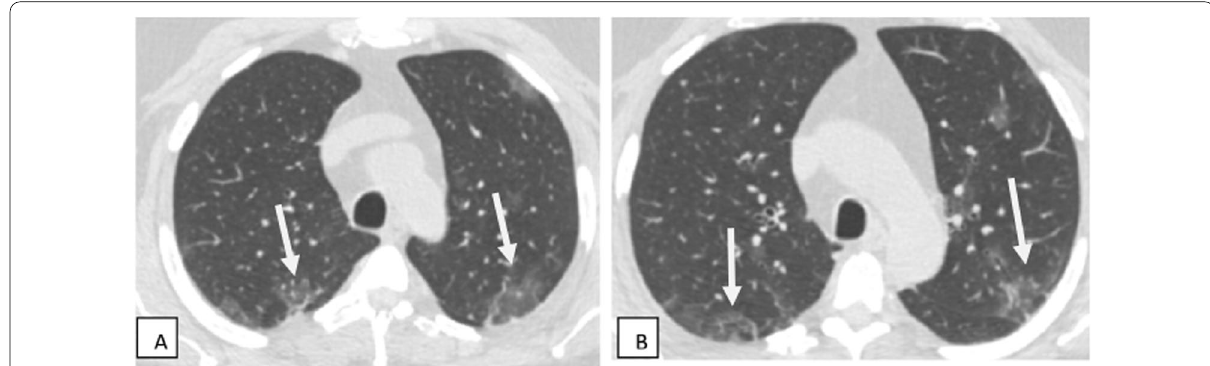
Fig. 1 Male patient aged 62 years old with recent history of cough and mild dyspnea. Axial CT images ( A , B ) show ill‑defined peripheral patchy areas of ground‑glass densities seen at both lungs with subpleural position (white arrows) (mild severity)